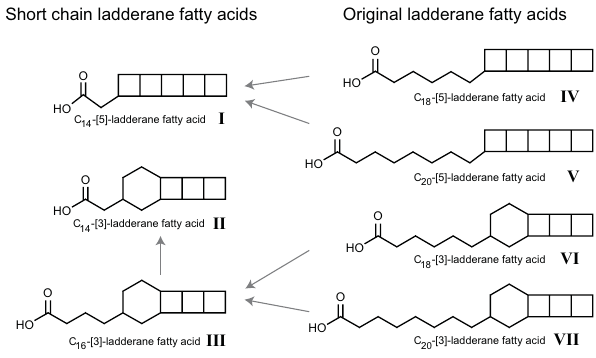
Fig. 1. Chemical structures of the ladderane lipids analysed in this study. Short chain ladderane fatty acids: (I) C 14 -[5]-ladderane fatty acid, (II) C 14 -[3]-ladderane fatty acid, (III) C 16 -[3]-ladderane fatty acid. Original ladderane fatty acids: (IV) C 18 -[5]-ladderane fatty acid, (V) C 20 -[5]-ladderane fatty acid, (VI) C 18 -[3]-ladderane fatty acid, (VII) C 20 -[3]-ladderane fatty acid. Two short chain ladderane fatty acids (I, II) were chosen as oxic degradation products of orig- inal ladderane fatty acids. Grey arrows indicate presumed degrada- tion